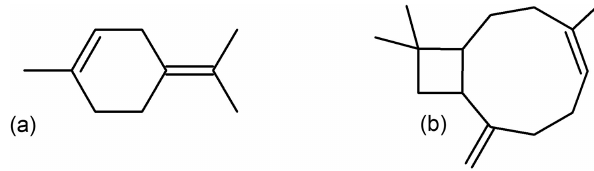
Figure 1. Molecular representation of terpinolene (a) and β -caryophyllene (b)